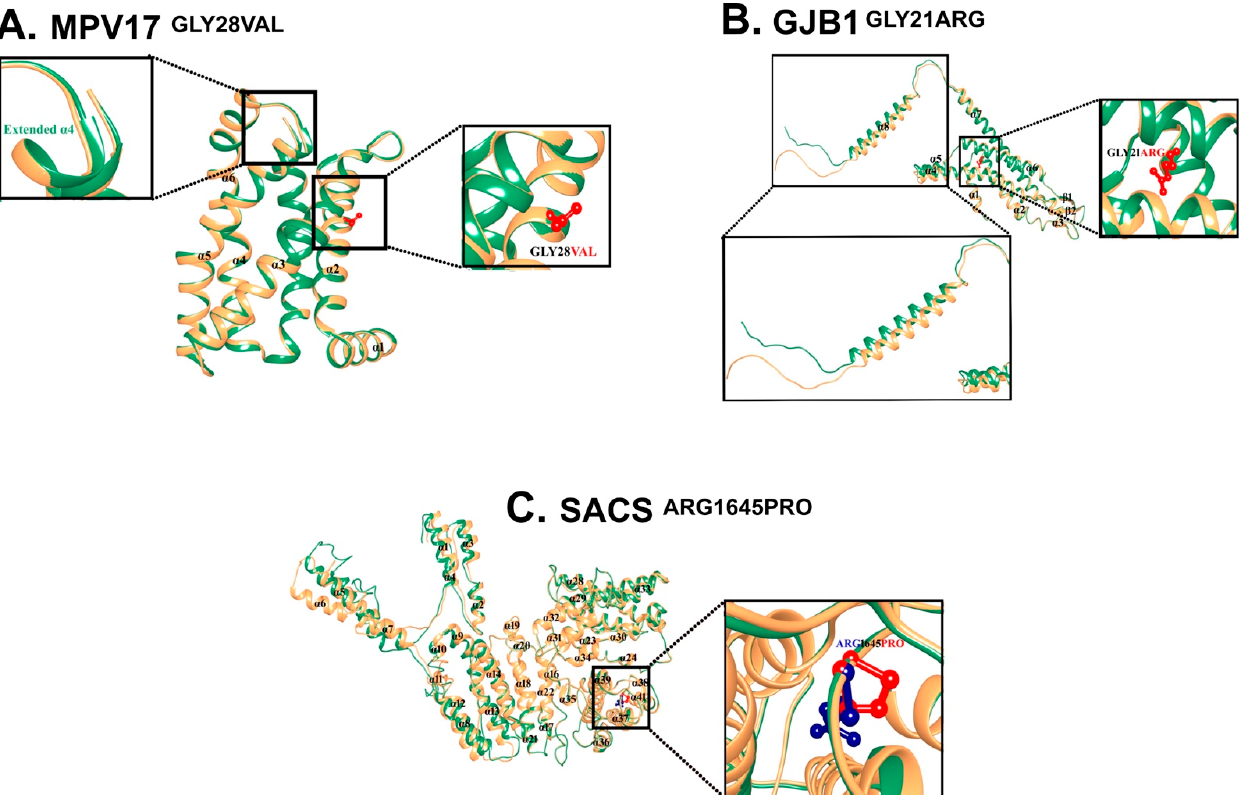
Figure 4. ( A ) Mutational and structural analysis of MPV17. Structural differences due to mutations in MPV17. Superimposition of MPV17 WT (sandy brown) and MPV17 GLY28VAL (sea green). GLY28 is labeled in black, and VAL28 is shown and labeled in red. Extended- α 5 is labeled and shown in sea green. All the α -helices are marked in black. ( B ) Mutational and structural analysis of GJB1. Structural differences due to mutations in GJB1. Superimposition of GJB1 WT (sandy brown) and GJB1 GLY21ARG (sea green). GLY21 is labeled in black, and ARG21 is shown and labeled in red. The region signifying the structural changes is zoomed in on and displayed in the inset. ( C ) Structural differences due to mutation in SACS. Superimposition of SACS WT (sandy brown) and SACS ARG1645PRO (sea green). ARG shown and labeled in blue, PRO shown and labeled in red. All the α -helices are labeled in